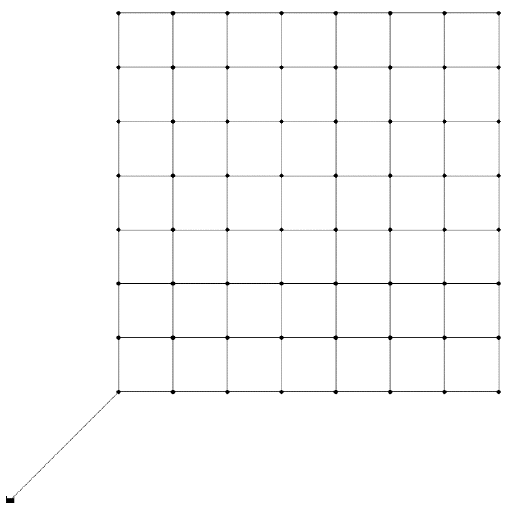
Figure 1. Layout of expanded Grid-1 network. Table 3. Optimal parameter set of the